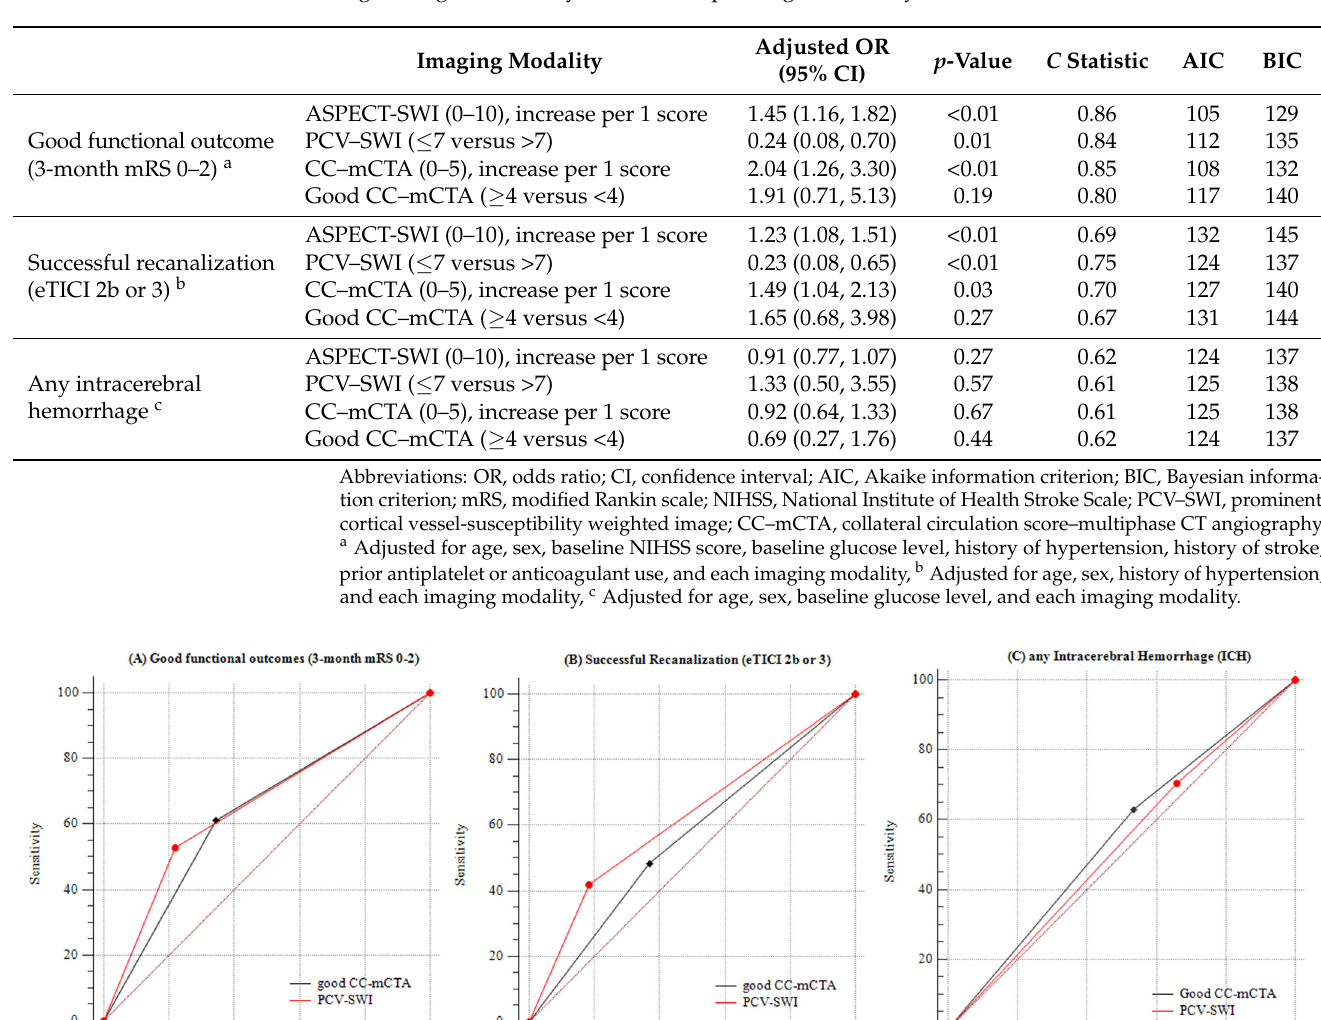
Table 3. Predictive ability of each imaging modality to discriminate outcomes using multivariable logistic regression analysis, receiver operating curve analysis, AIC, and BIC.